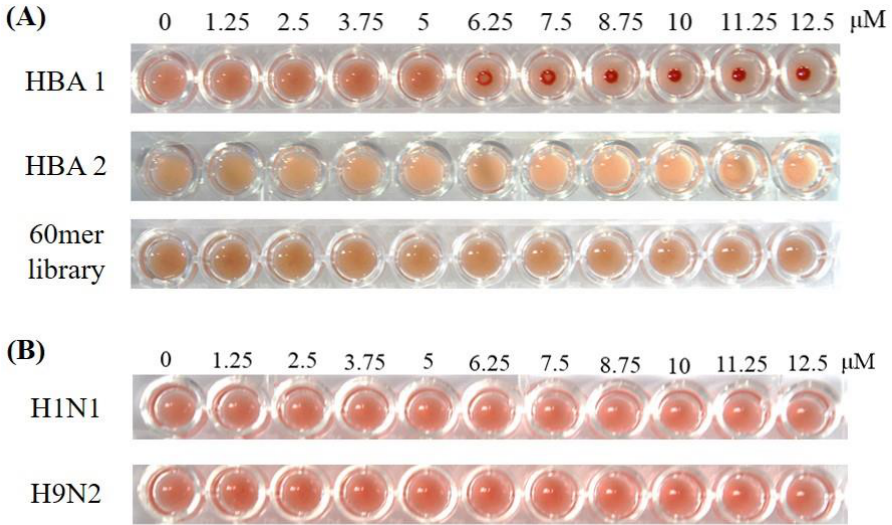
Figure 5. Hemagglutination inhibition assay for influenza virus with developed aptamers. ( A ) HBA1 showed hemagglutination inhibition of H5N1 at the lowest concentration, 6.25 μM. HBA2 showed a weak inhibition effect on hemagglutination up to a concentration of 11.25 μM. However, the 60 mer library that was nonspecific for H5N1 had no inhibitory effect. ( B ) HBA1 had no inhibitory effect on the other virus subtype.